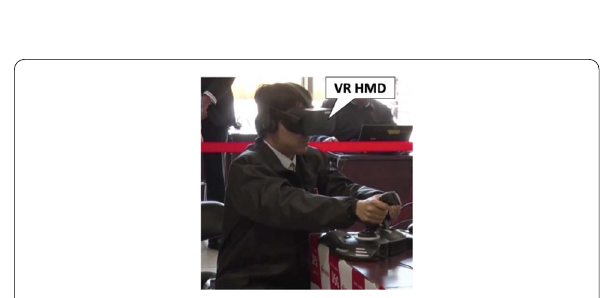
Fig. 29 User of the co-experience